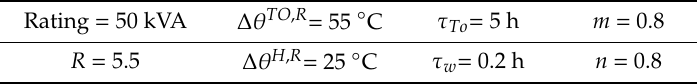
Table 4. Transformer parameters data from